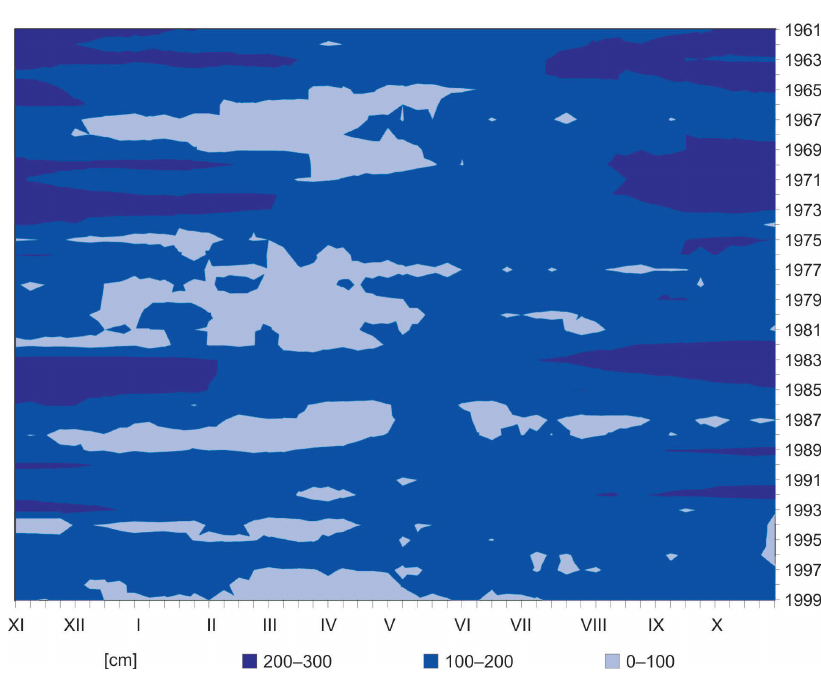
Fig. 4. Weekly groundwater levels (1961–2000) at the IMGW-PIB Buk groundwater station located in the Poznan Plateau (data source: